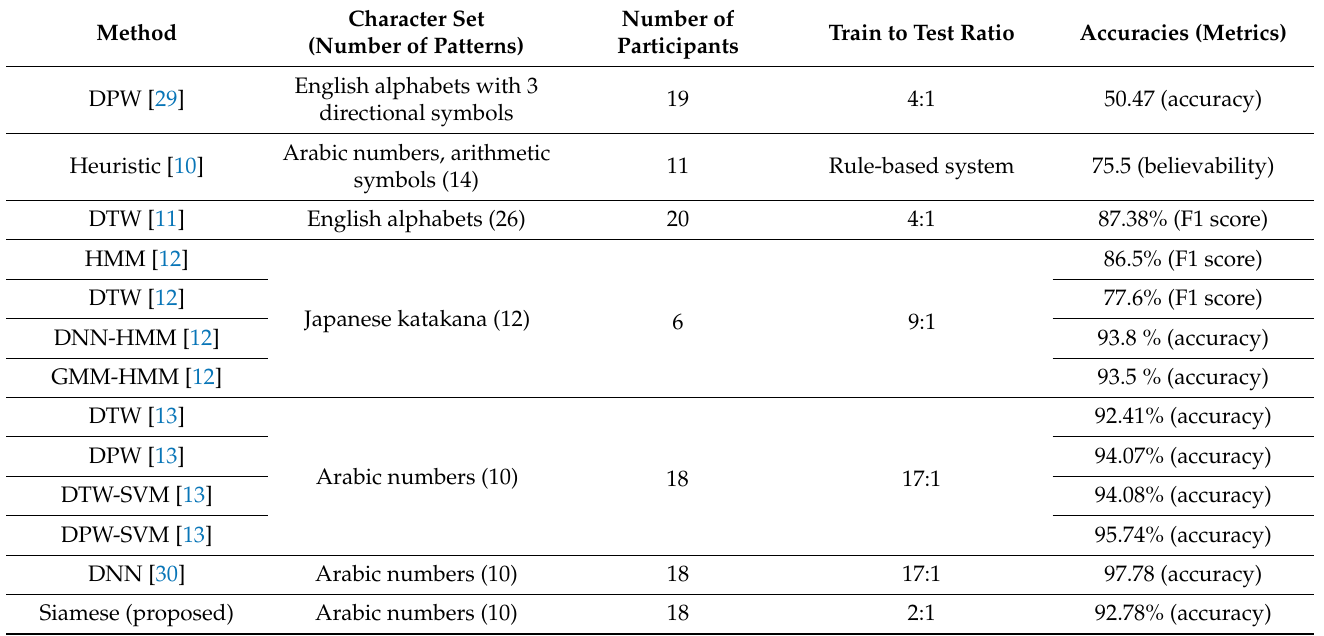
Table 6. Recognition accuracies of eye-written characters with different